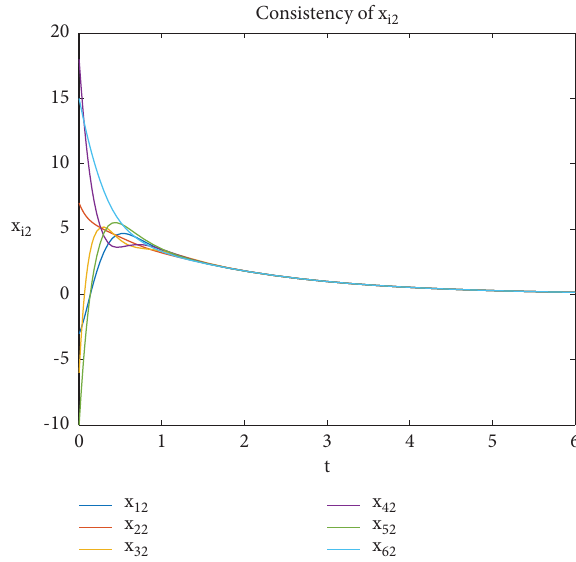
Figure 2: Te evolution of states x